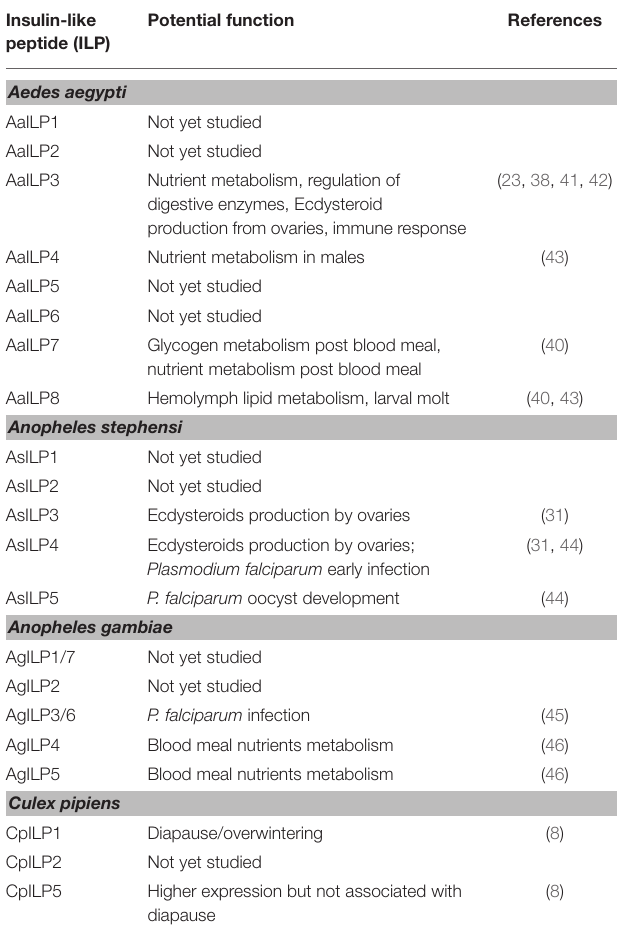
TABLE 2 | Potential functions of mosquito insulin-like